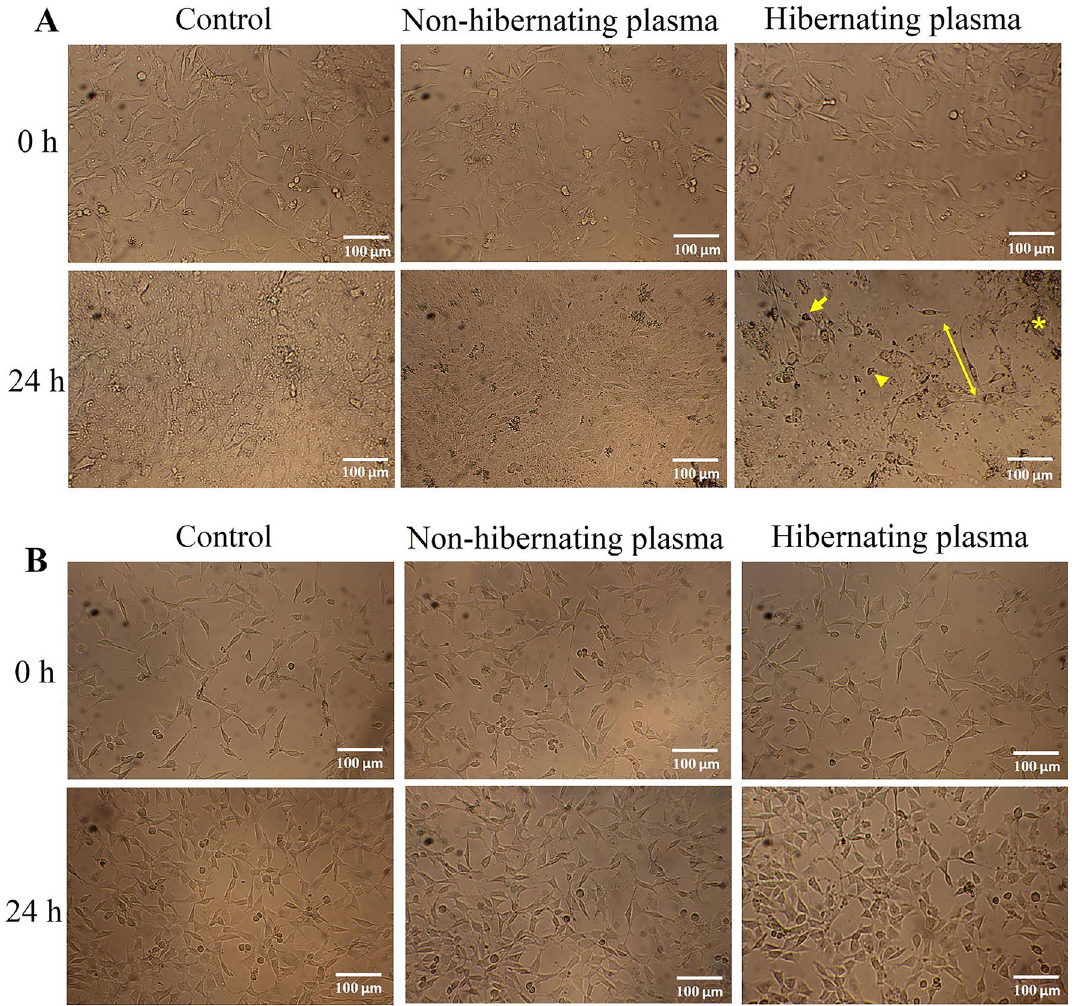
Figure 2. Effects of hibernating plasma on the morphology of 4T1 breast cancer and L929 normal cells. ( A ) 4T1 and ( B ) L929 cells photographs were obtained using a digital light microscope before (0 h) and 24 h after treatment with non-hibernating plasma (16 mg/ml) and hibernating plasma (16 mg/ml). The control cells were incubated with standard culture media. Arrow: rounded cell. Arrowhead: cell with irregular shape. Star: cell debris. Two-head arrow: cell with elongated cellular